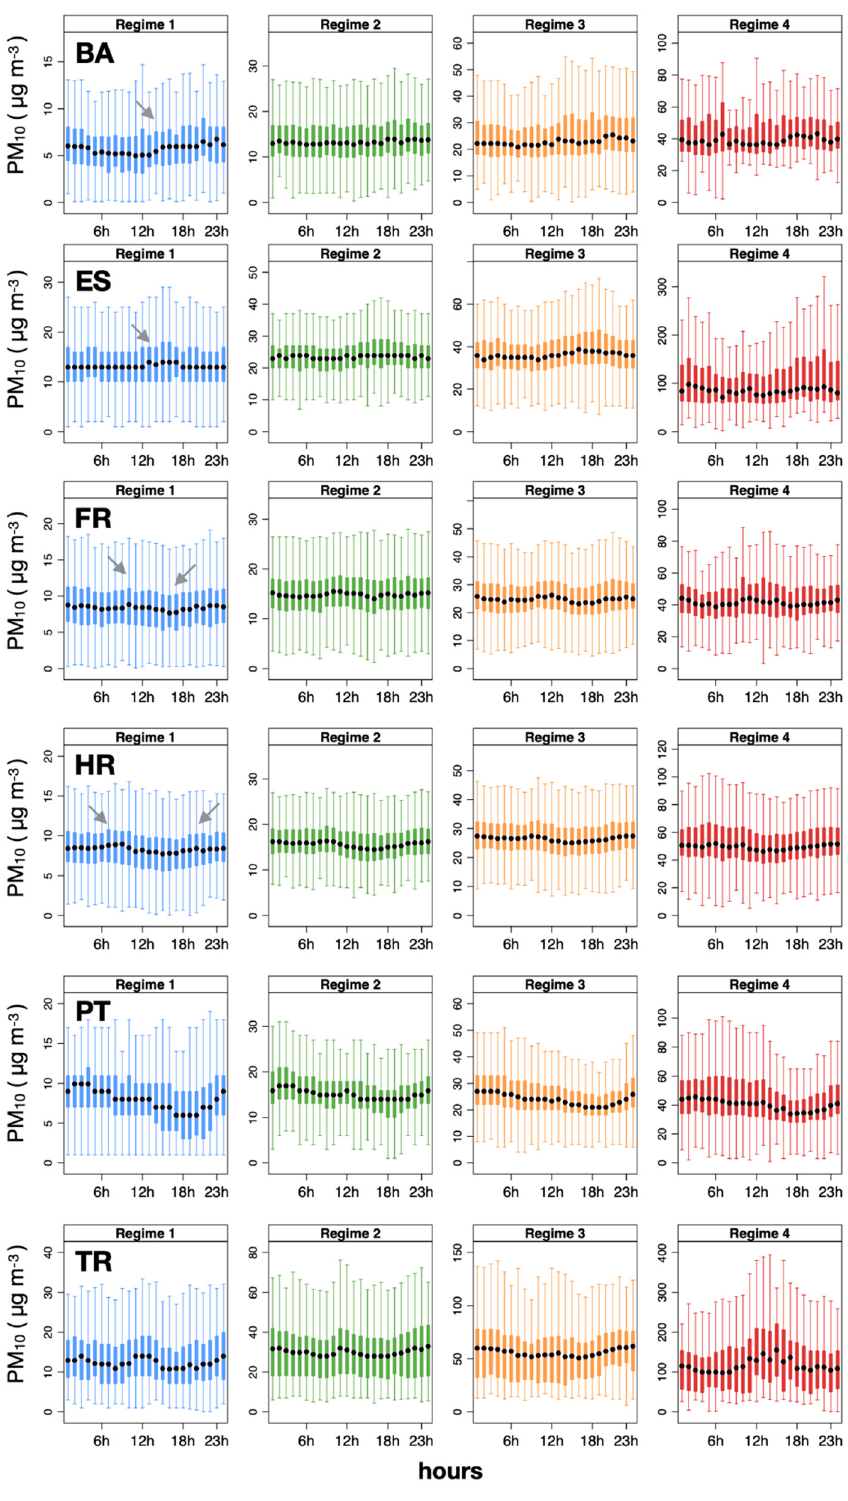
Figure 6. Evolution of the PM 10 concentration by regimes and hour of the day. Panels in rows describe the analysis for a single TS. Grey arrows indicate slight fluctuations in concentrations. ES—